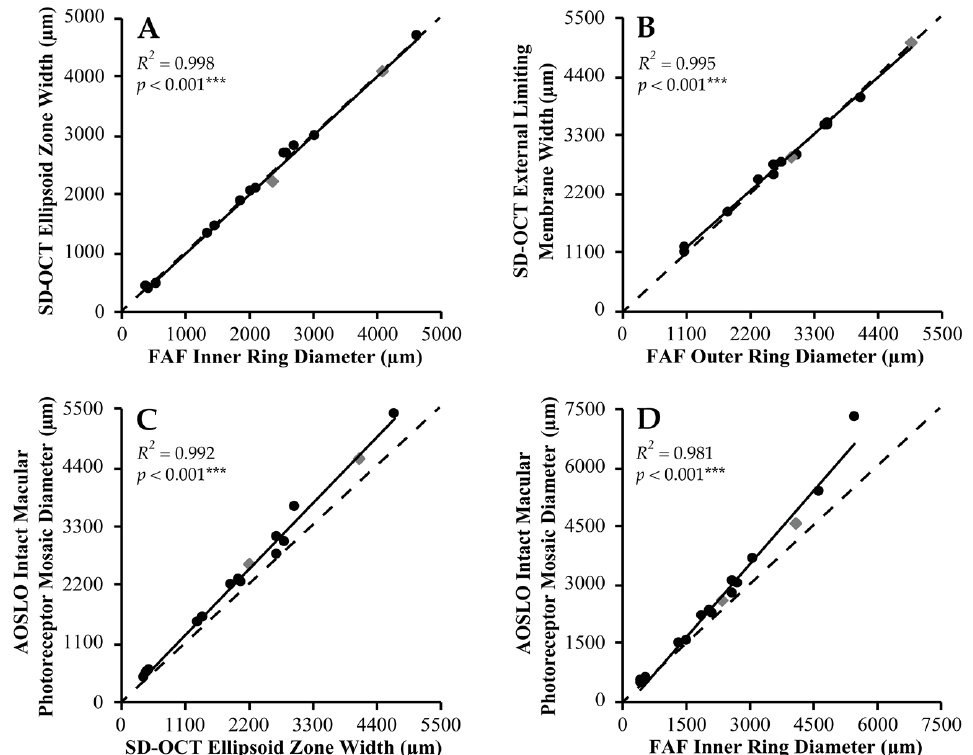
Figure 2. Spatial correlation between retinal imaging in USH2A retinopathy. Scatterplots of association between structural parameters on fundus autofluorescence (FAF), spectral-domain optical coherence tomography (SD-OCT) and adaptive optics scanning laser ophthalmoscopy (AOSLO) in USH2A -associated Usher syndrome (black circles) and non-syndromic retinitis pigmentosa (grey diamonds) are shown. ( A , B ) FAF versus SD-OCT shows close agreement between inner ring diameter and ellipsoid zone width ( n = 15), and outer ring diameter and external limiting membrane width ( n = 14). ( C ) SD-OCT versus AOSLO shows linear association between ellipsoid zone width and intact macular photoreceptor mosaic diameter ( n = 15), similar to that in ( D ) FAF versus AOSLO between inner ring and intact macular photoreceptor mosaic diameters ( n = 16). Lines of best fit (solid black line) and unity ( x = y , dashed black line) are shown in each graph. R 2 and p -values for each correlation are shown, with asterisks denoting the degree of statistical significance.